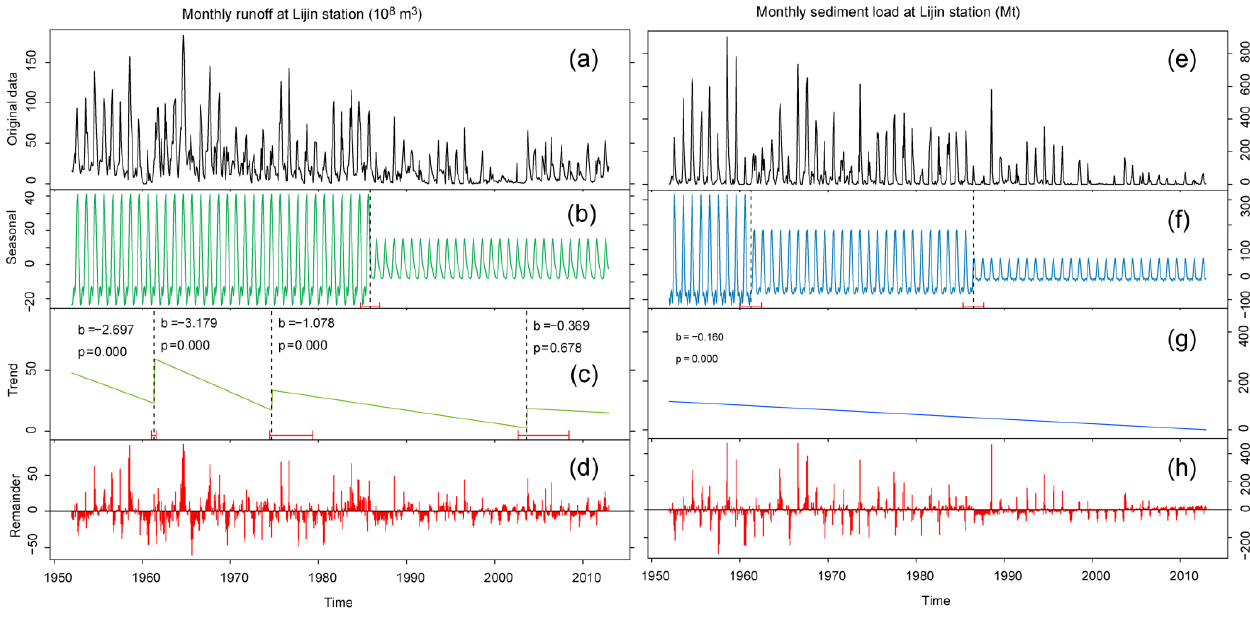
Figure 7. Monthly runoff and sediment load decomposition at the Lijin station. ( a , e ) Observed monthly runoff and sediment, ( b , f ) seasonal components of runoff and sediment decomposed by BFAST; ( c , g ) trends components of monthly runoff and sediment load decomposed by BFAST; ( d , h ) residues of runoff and sediment